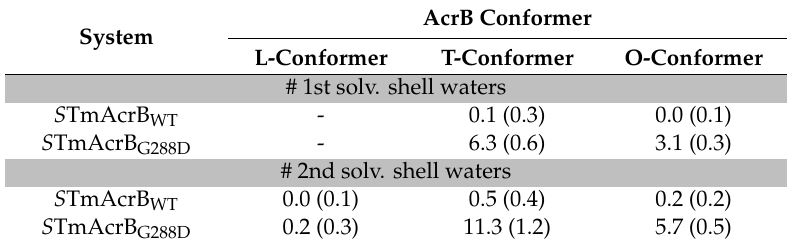
Table 4. Number of waters in the first and second solvation shell around residue 288 (in DBP), in S TmAcrB WT and S TmAcrB G288D . The two solvation shells were defined by using a distance cut-o ff of 3.4 Å and 5.0 Å,